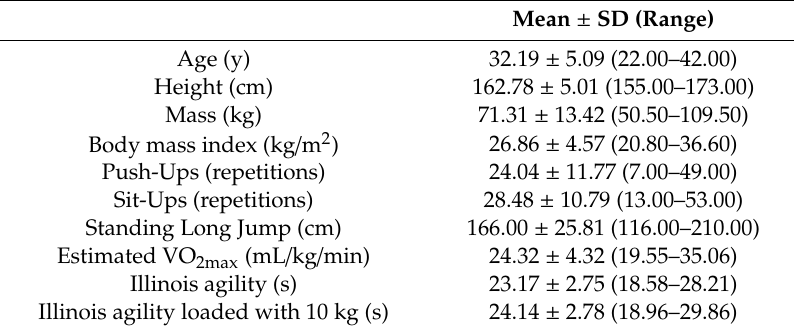
Table 1. Demographic and fitness measure results.